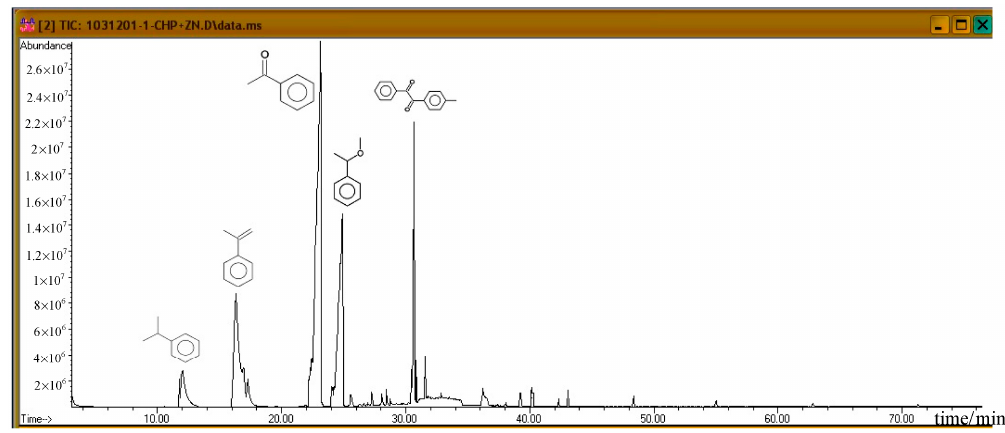
Figure 8. Product analysis of CHP decomposition after mixing CHP with ZnBr 2 by GC/MS.